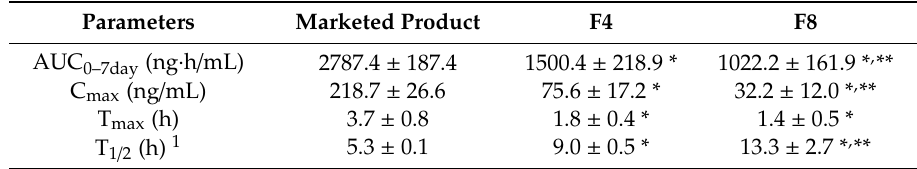
Figure 5. Plasma concentration–time profiles of TA following IA administration of the marketed product, F4 (drug:polymer = 1:5) and F8 (drug:polymer = 1:10) in rats at a dose of 0.5 mg/kg; Note: Each point represents mean ± SD ( n = 5). Table 3. Pharmacokinetic parameters of TA in plasma following IA administration of the marketed product, F4, and F8 in